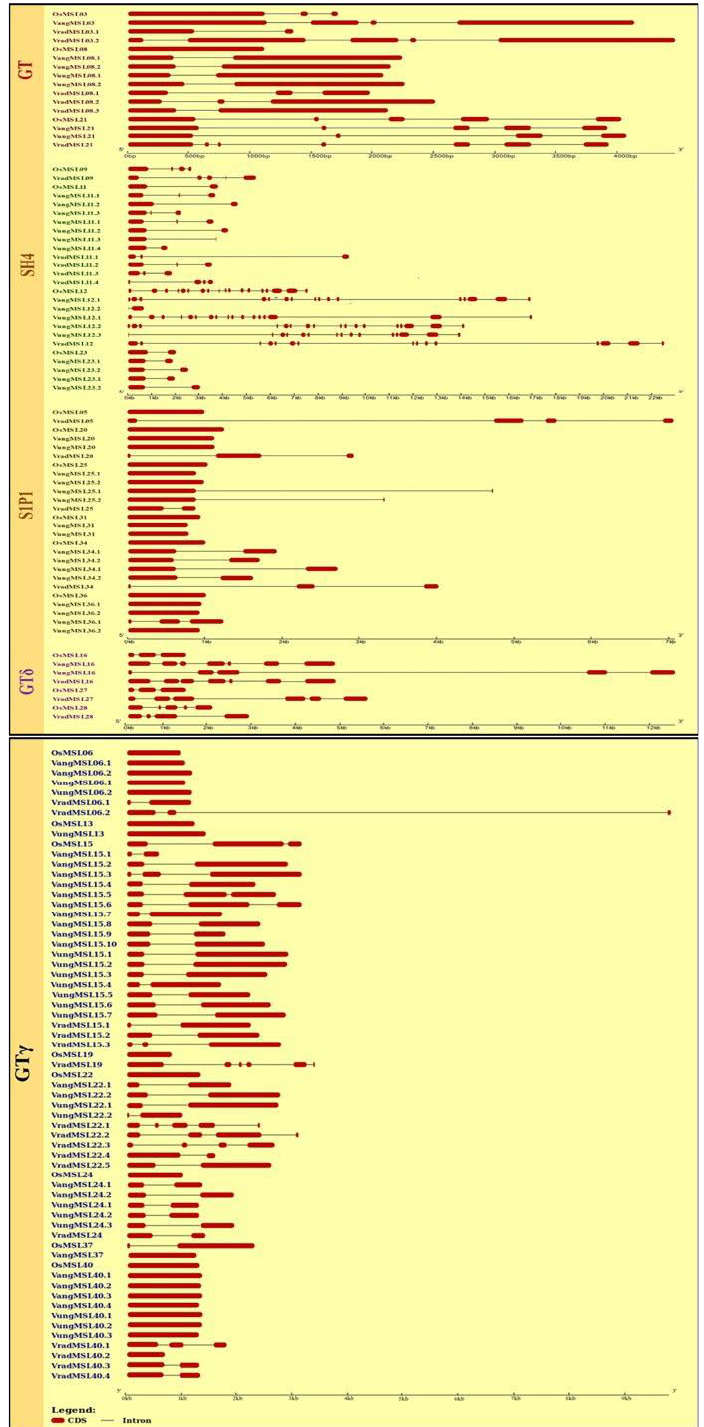
Figure 2. Gene structure of trihelix family genes in Vigna species along with its rice orthologs. The red bars represent exons and the black line between them represents introns. The scale at the bottom indicates the length of exons and introns. Vung, V. unguiculata; Vrad, V. radiata; Vang, V. angularis; Vumb, V. umbellata; Os, Oryza sativa. MSL, Myb/SANT-LIKE. The non-synonymous to synonymous substitution rate (dN/dS) was calculated for every trihelix gene with respect to its rice ortholog. The calculated range of dN/dS rate varied from 0.0100 to 1.1412 in the GT subgroup, 0.0074 to 0.724 for GTγ, 0.0064 to 0.1020 for S1P1, 0.0039 to 0.086 for SH4 and from 0.0175 to 0.0782 in the GTδ subgroup (Table s S2–S5). The dN/dS value for all four Vigna trihelix genes with their rice ortholog pairs was found to be less than 1 except for VangMSL21, which indicated purifying or stabilizing